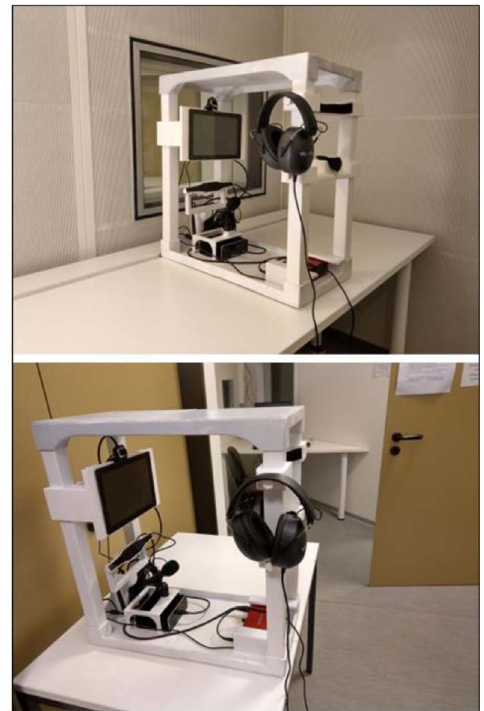
Figure 3. The same experiments were done in the listening booth (top) and in the lobby of the listening booth